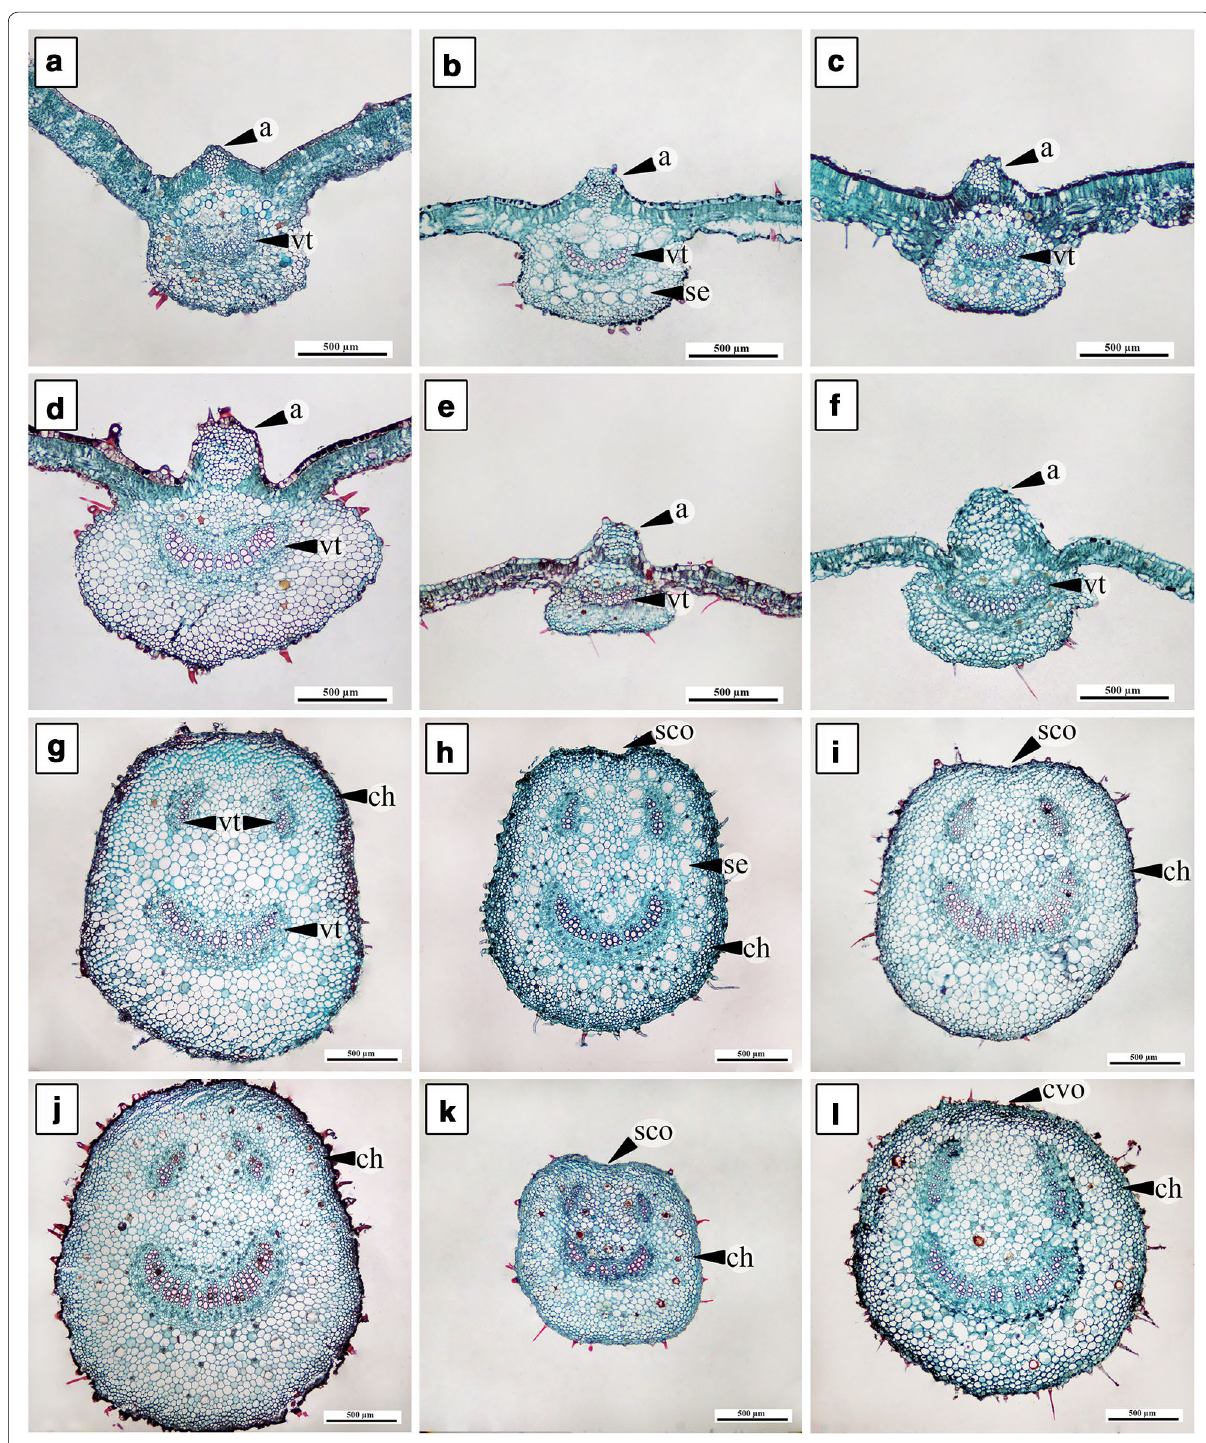
Fig. 5 Transverse sections of midrib ( a – f ) and petiole ( g – l ). a , g A. breviscapa , b , h A. kerrii , c , i A. suddeeana , d , j A. variabilis , e , k Argyreia 1 and f , l Argyreia 2 ( a adaxial curvature, ch chlorenchyma cell, cvo convex outline, sco slightly concave outline, se secretory cavity, vt vascular tissue). Scale bar 500